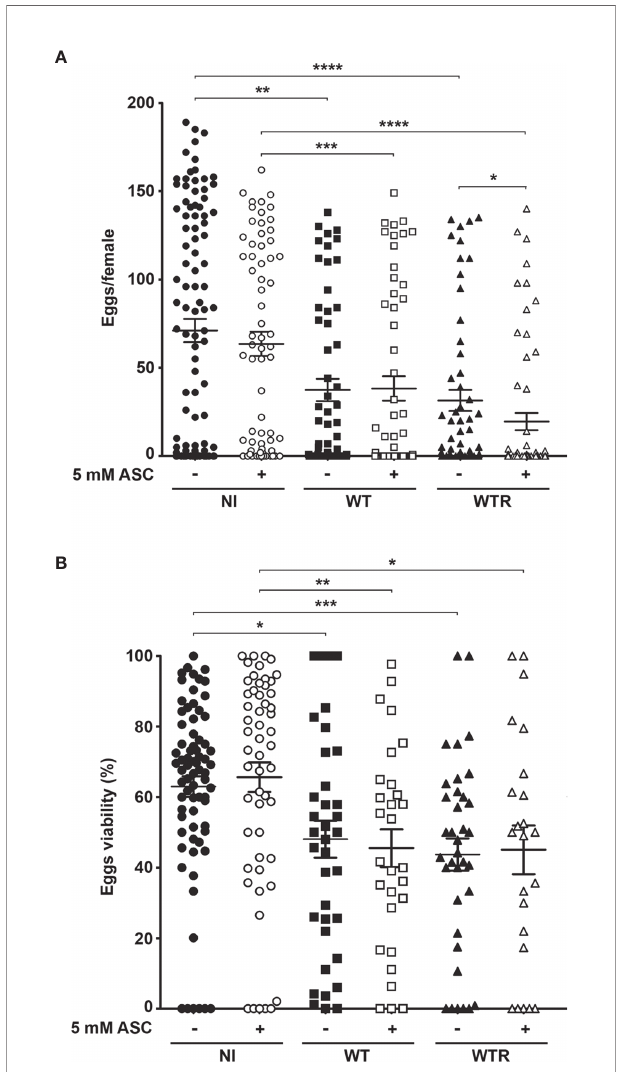
FIGURE 9 | Strigomonas culicis infection disrupts the reproductive fi tness of Aedes aegypti females. (A) Egg production (*p = 0.006, **p = 0.003, ***p = 0.002, ****p = 0.001) and (B) viability (*p = 0.01, **p = 0.002, ***p = 0.001) were evaluated in non-infected (NI), wild-type (WT) and hydrogen peroxide (H 2 O 2 )-resistant (WTR)- infected females fed with 10% sucrose or 10% sucrose + 5 mM sodium L-ascorbate (ASC) ad libitum . Synchronized oviposition was stimulated 4 dpi. Signi fi cant p-values were obtained by Mann – Whitney test, and error bars represent the mean ± SEM of two independent experiments.